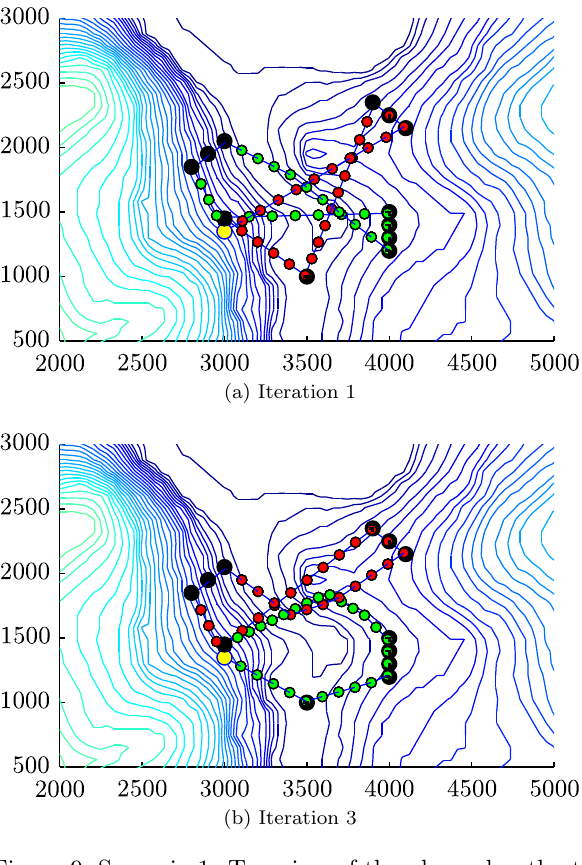
Figure 9: Scenario 1: Top view of the planned path at (a) 1st iteration, and (b) 3rd and final itera- tion. See also caption text for Figure 7.